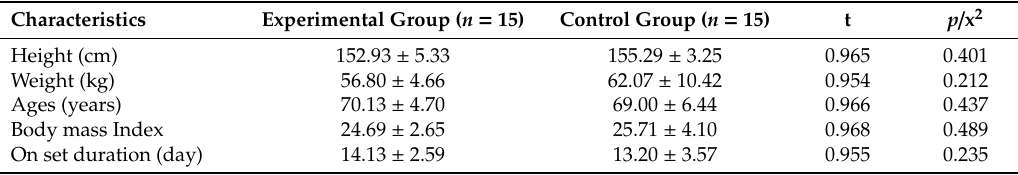
Table 2. General characteristics of participants ( n =